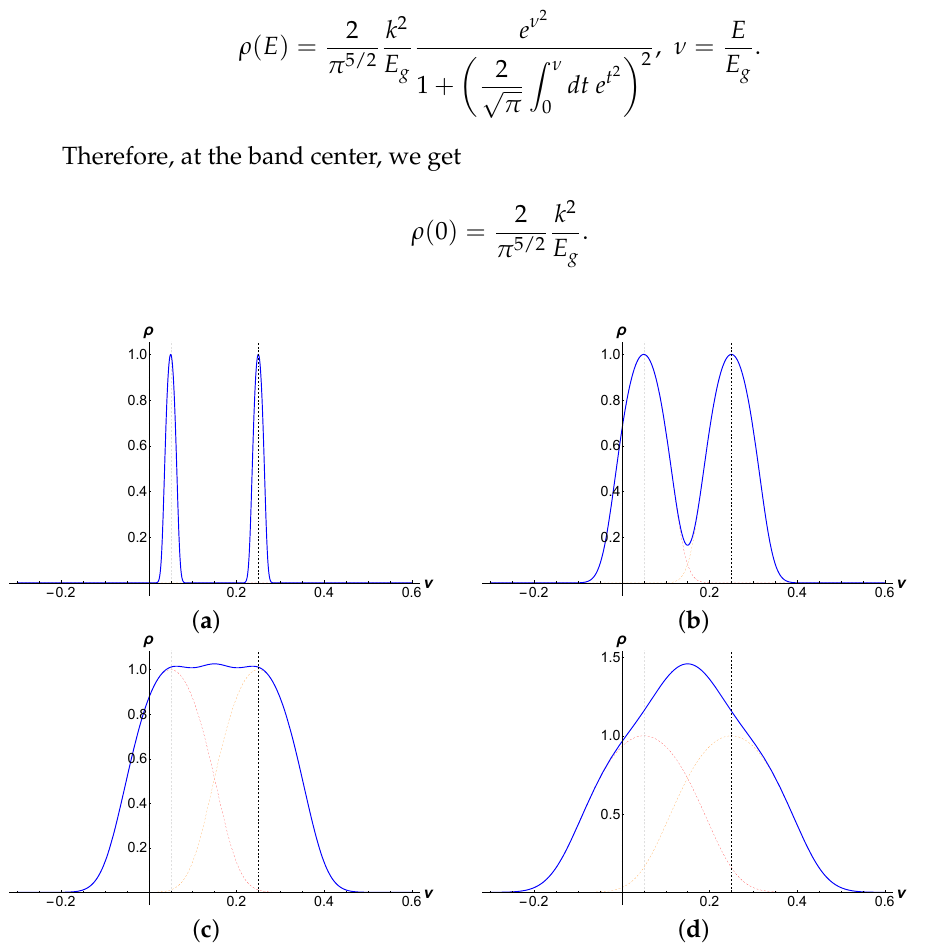
Figure 4. Evolution of the DOS of both Landau sublevels defined in Equation (11) ( a – d ) plotted in units of the DOS at each suband center 1 of the dimensionless energy ν . The following quantities are used: (cid:101) E g / t = 0.01,0.045,0.073, and 0.1 in units of the hopping amplitude. Dashed lines emphasize the position of each